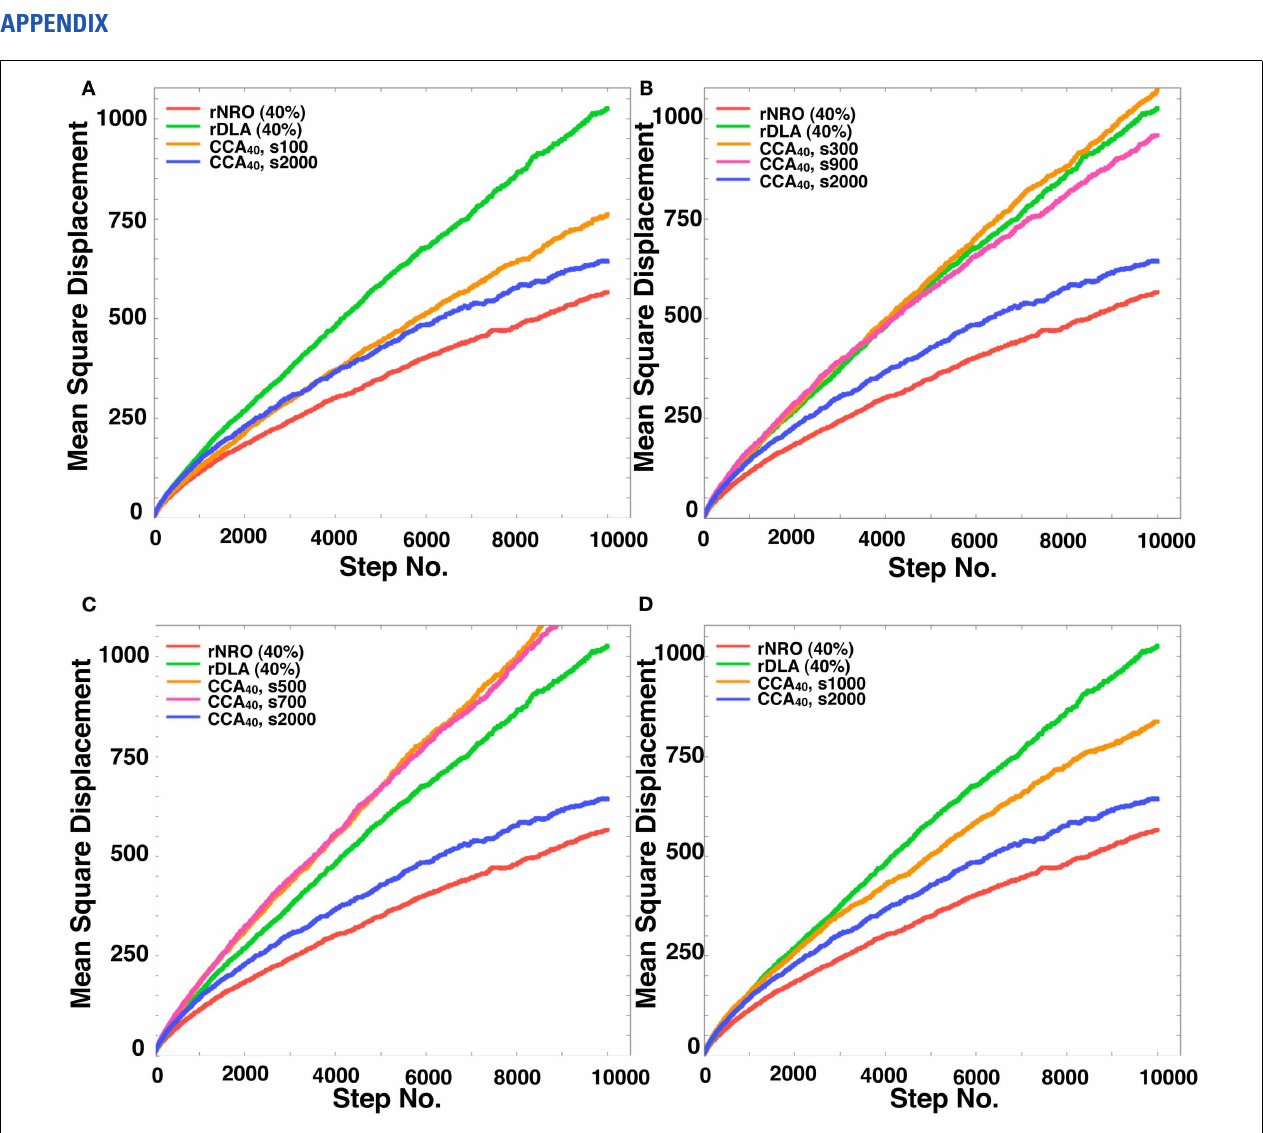
magenta line. (C) rNRO (40%), solid red line; rDLA (40%), solid green line; CCA 40 , s2000 (completed CCA), solid blue line; CCA 40 , s500 (early CCA), solid orange line; CCA 40 , s700 (early CCA), solid magenta line. (D) rNRO (40%), solid red line; rDLA(40%), solid green line; CCA 40 , s2000 (completed CCA), solid blue line; CCA 40 , s1000 (completed CCA), solid orange